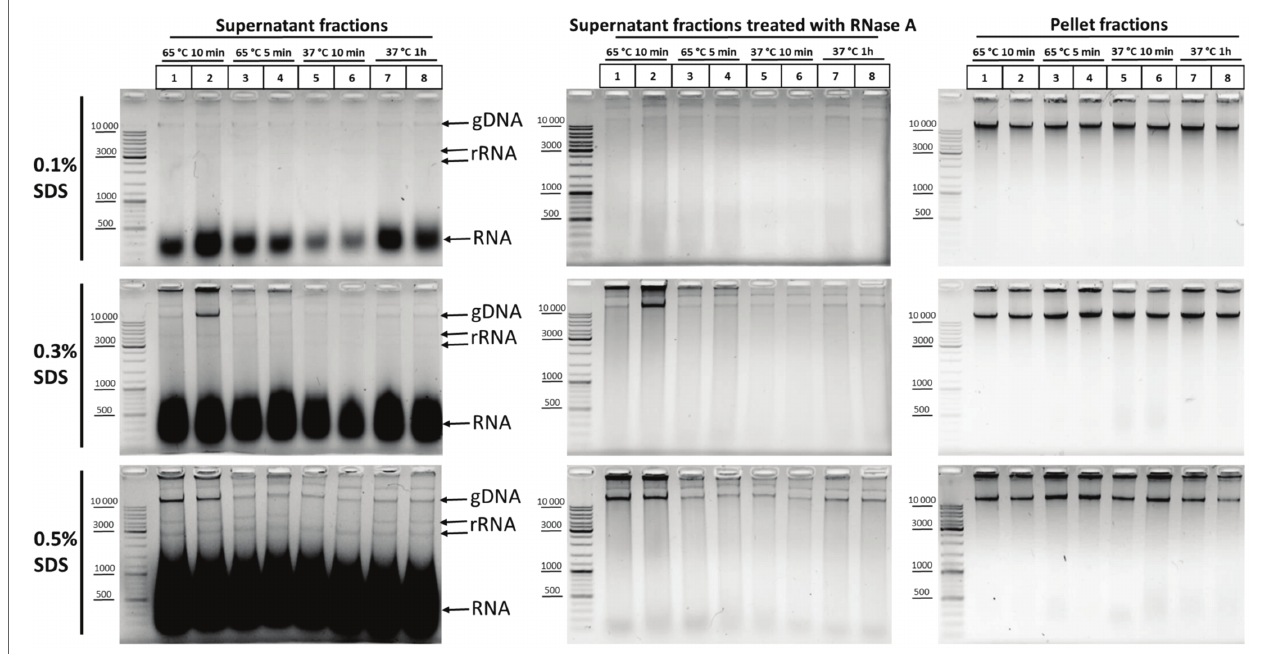
FIGURE 4 | DNA and RNA release from nuclei at different SDS concentrations and under different nuclei treatment regimens. С ells were fixed, quenched, washed after quenching with 1X PBS as in Figures 2A – C , and then lysed in hypotonic lysis buffer #11 (see Table 2 ). Cells were incubated on ice for 15 min and nuclei were washed once with the lysis buffer and then resuspended in water supplemented with the appropriate amount of SDS (0.1, 0.3, or 0.5%). Then, the nuclei were treated with heat in the following conditions: 65 ° C for 10 min (lanes 1, 2), 65 ° C for 5 min (lanes 3, 4), 37 ° C for 10 min (lanes 5, 6), and 37 ° C for 1 h (lanes 7, 8). Triton X-100 was added up to 1.8% and nuclei were incubated at 37 ° C for 15 min. Thereafter, the samples were separated into the supernatant (250 μ l) and the pellet and 500 μ l of EB was added to the supernatant fractions. Then, the cross-links were reversed at 56 ° C O/N and DNA was extracted, precipitated, dissolved, and treated with bovine RNase A (middle row of panels from top to bottom) as in Figures 2A – C or left untreated (left row of panels from top to bottom). The pellet fractions (right row of panels from top to bottom) were processed further as follows: Nuclei were washed with 1X RB for DpnII buffer and incubated in 1X RB at 37 ° C for 1 h with agitation (restriction reaction imitation). After that, nuclei were washed with 1X T4 DNA ligase buffer (50 mM Tris-HCl pH рН 7.5, 10 mM MgCl 2 , 1 mM ATP, and 10 mM DTT) three times and incubated at 16 ° C for 30 min and at 22 ° C for 30 min in 1X T4 DNA ligase buffer (ligation reaction imitation). Then, 500 μ l of EB was added and the pellet fractions were processed as for the supernatant fractions. The amount of the DNA subjected to electrophoresis was 2 μ l for supernatant fractions and 1 μ l for pellet fractions. Upper row of pictures from left to right – treatment with 0.1% SDS; middle row of pictures – 0.3% SDS; and the bottom row of pictures – 0.5% SDS. All other designations were as in Figure 3A . Two replicates of each experimental condition were carried out. The exposure time for all gels is the